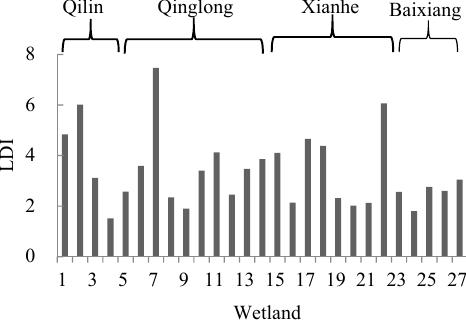
Figure 4. LDI of different wetland watersheds.